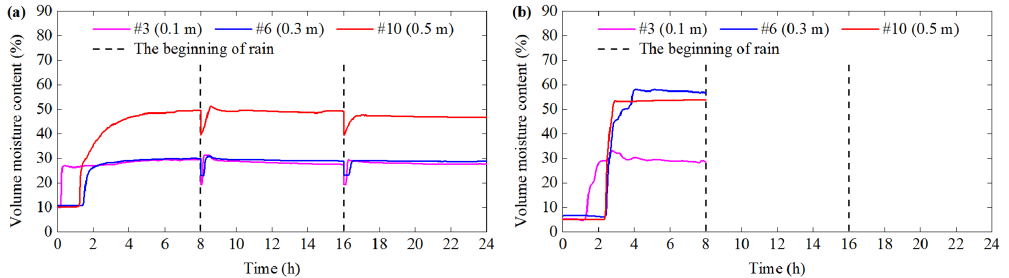
Figure 10. Volume moisture content at position C of (a) test 5 and (b) test 6.